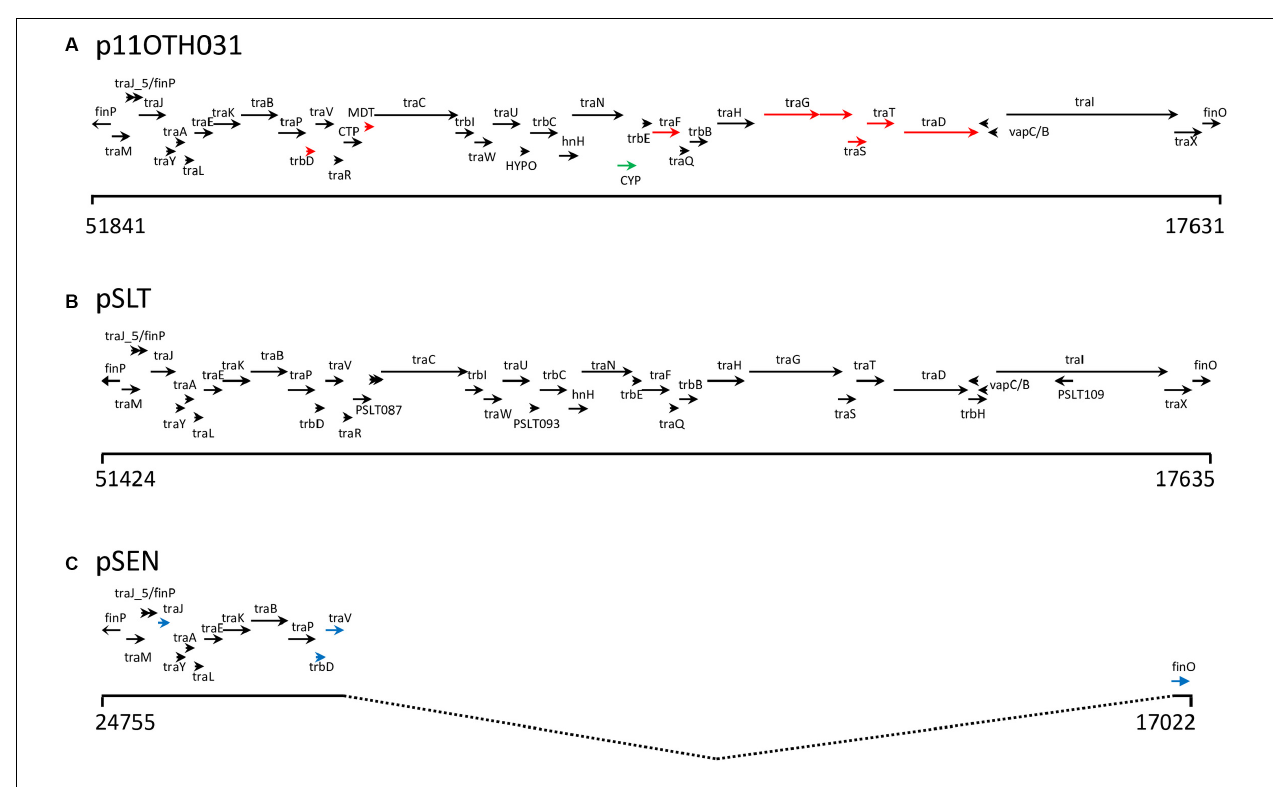
FIGURE 4 | (A) Schematic showing the genes encoded by a 34.5 Kb region of p11OTH031 including the 28 Kb insertion harboring multiple genes of the incF operon. Base positions corresponding to the start and end of this region are indicated; the arrows show most of the operon transcripts running off the reverse strand. The corresponding regions of the pSLT (B) and pSEN (C) reference plasmids are also shown. Black arrows indicate similar gene lengths between all three plasmids. Red arrows indicate a different length for p11OTH031 while blue arrows indicate gene lengths specific for pSEN. The green arrow in p11OTH031 identifies a distinct gene encoding a cytosine permease not found in either pSLT or pSEN. All six S. Enteritidis plasmids analyzed in detail in this report exhibited very similar gene organization over this region with the following exceptions. The p06D1274 plasmid had a truncated traI ; p08OTH027 had a truncated cytosine permease gene and a truncated traD gene while the other samples exhibited small variations in the length of the traD gene.